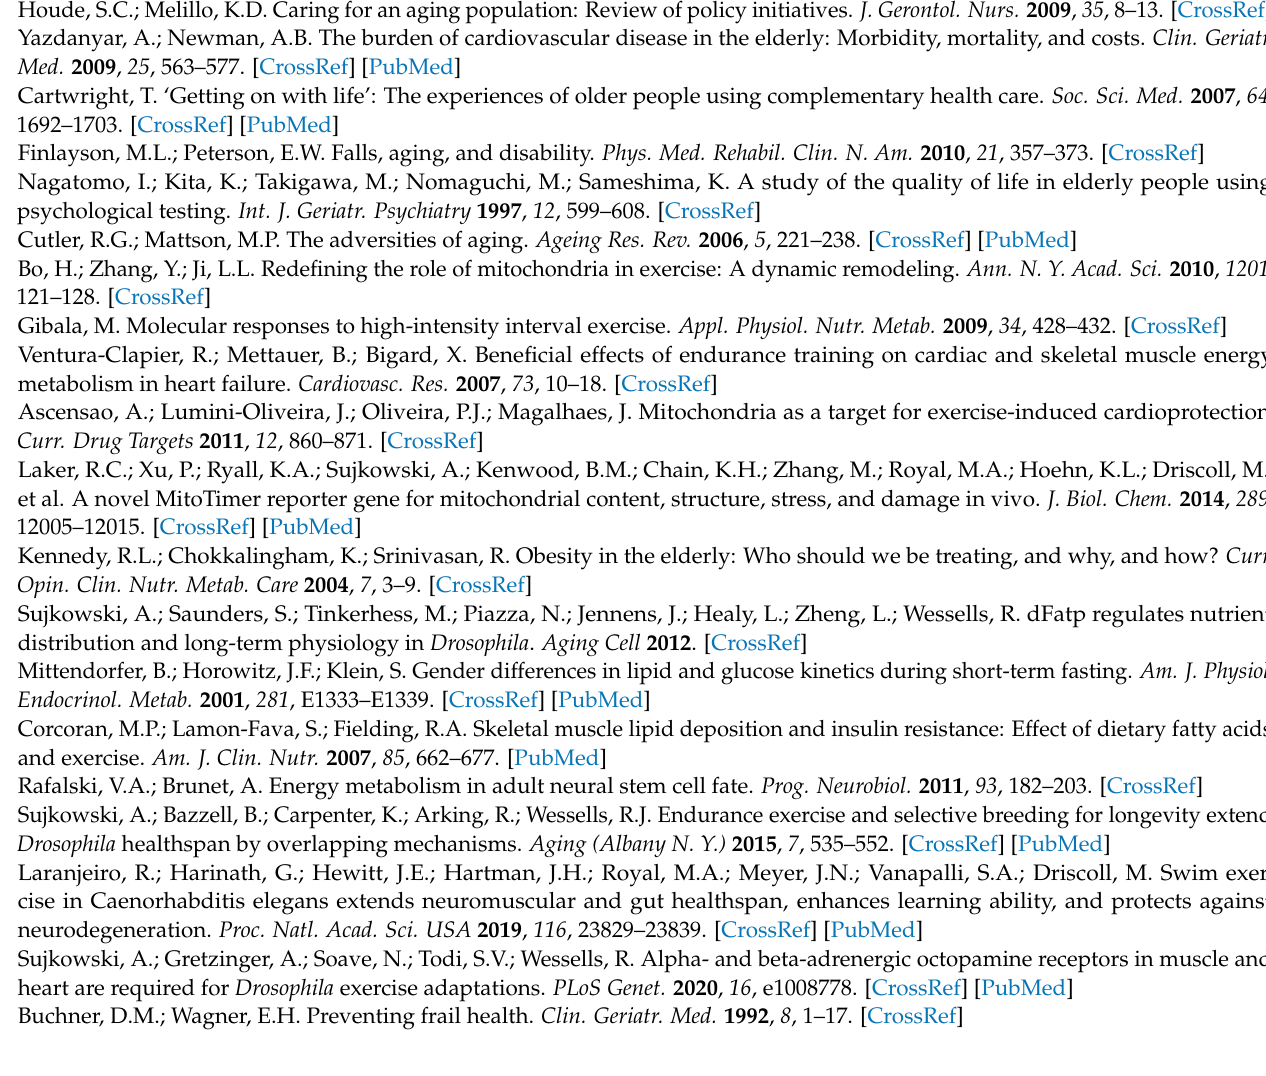
Figure 2. Source data file for Figures 1–7 are included as Supplementary